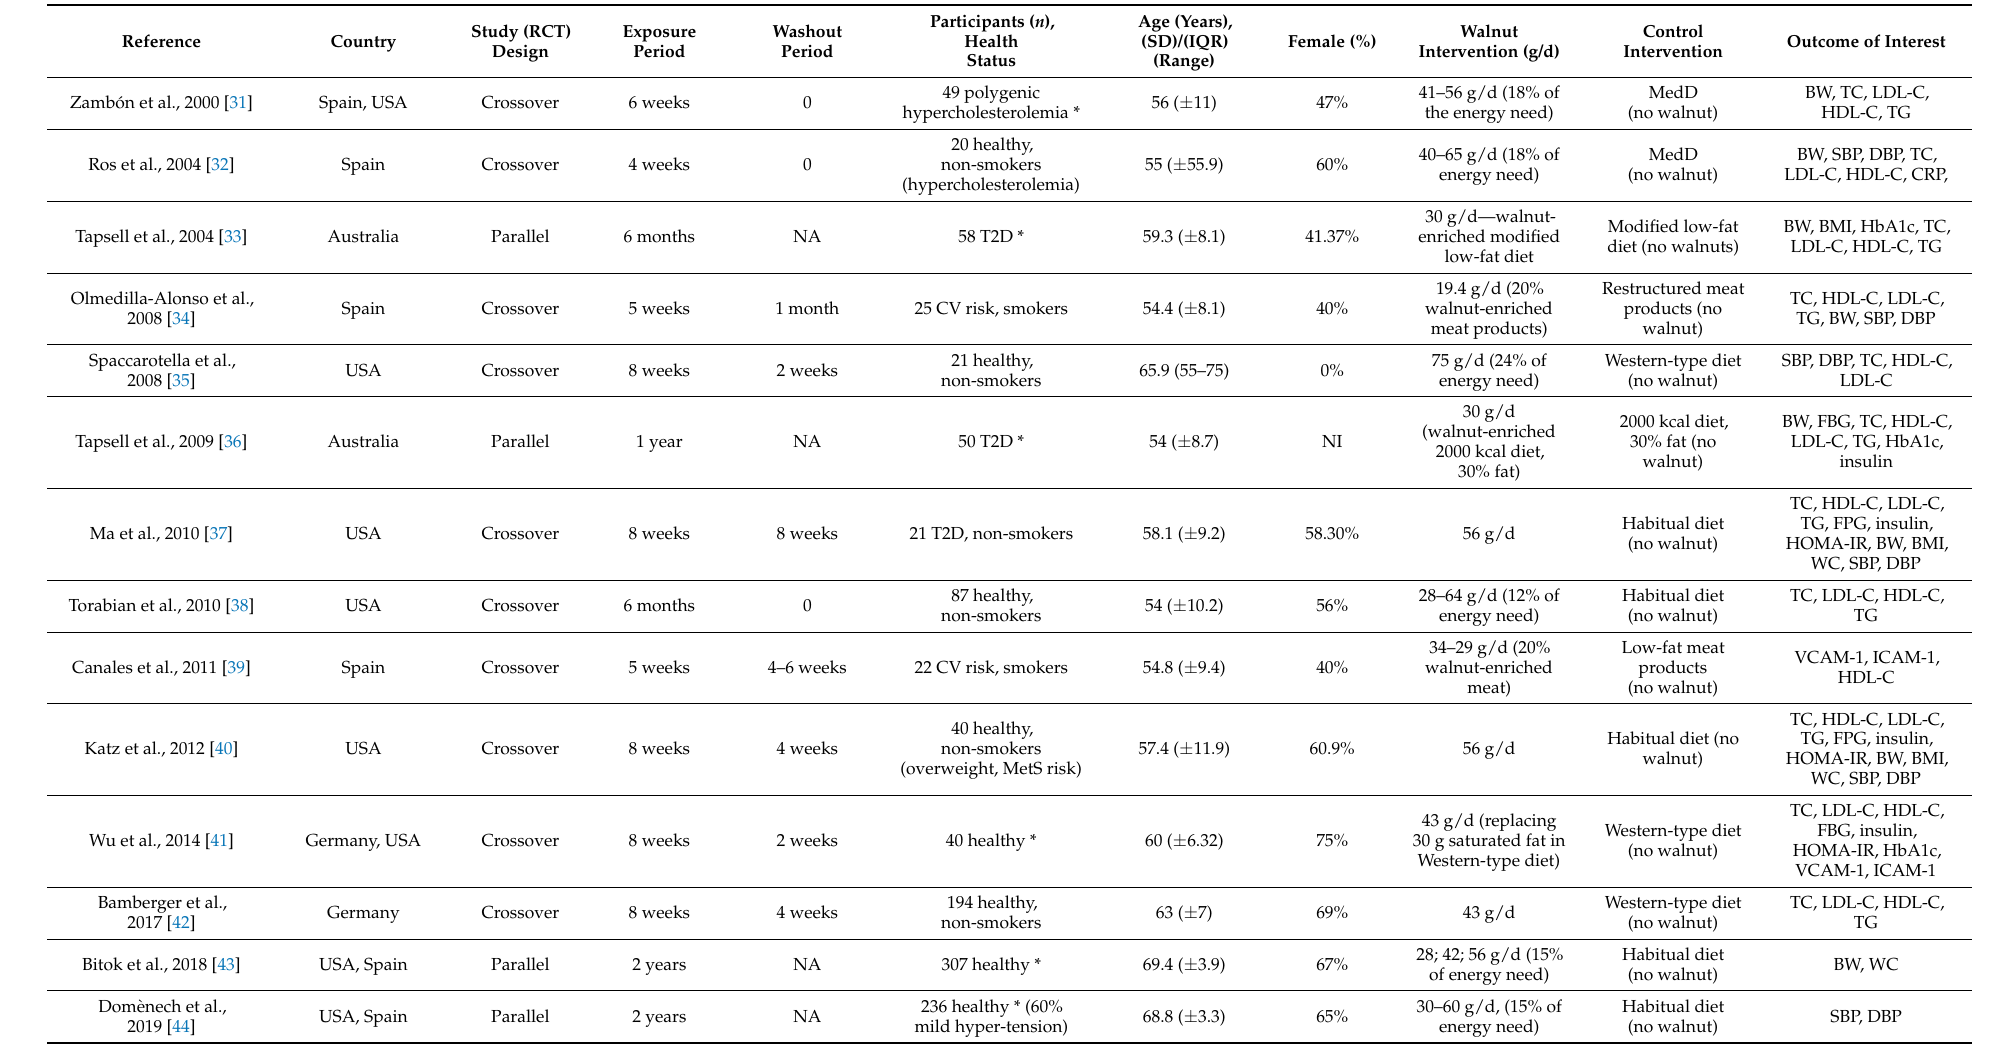
Table 1. Characteristics of the selected